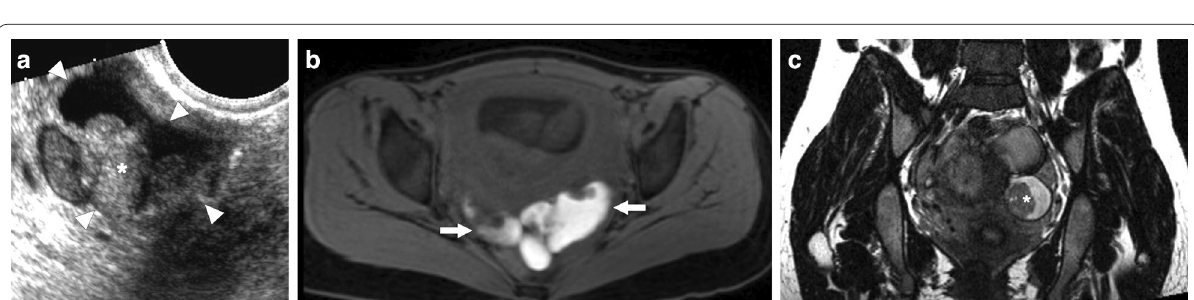
Fig. 34 Decidualized endometriomas. A 24-year-old pregnant patient with previous history of menstrual irregularity presenting for routine obstetric US. a US showed a normal intrauterine pregnancy with biometry compatible with 12 weeks and 5 days gestation (not shown). However, there were bilateral (left not shown) adnexal complex cystic lesions (arrowheads) with solid components (asterisk). About 10 days later, axial T1W fat-suppressed ( b ) and coronal T2W ( c ) non-contrast pelvic MR images showed bilateral T1 hyperintense endometriomas (arrows) with T2 hypointense nodules (asterisk) in the lesions bilaterally (right not shown). She was managed expectantly. She was induced at 41 weeks and the baby was healthy. Follow-up MRI at 12 and 30 months post-partum (not shown) showed diminished size of the lesions with some complexity remaining on the left. Two years after the first delivery she delivered a second child